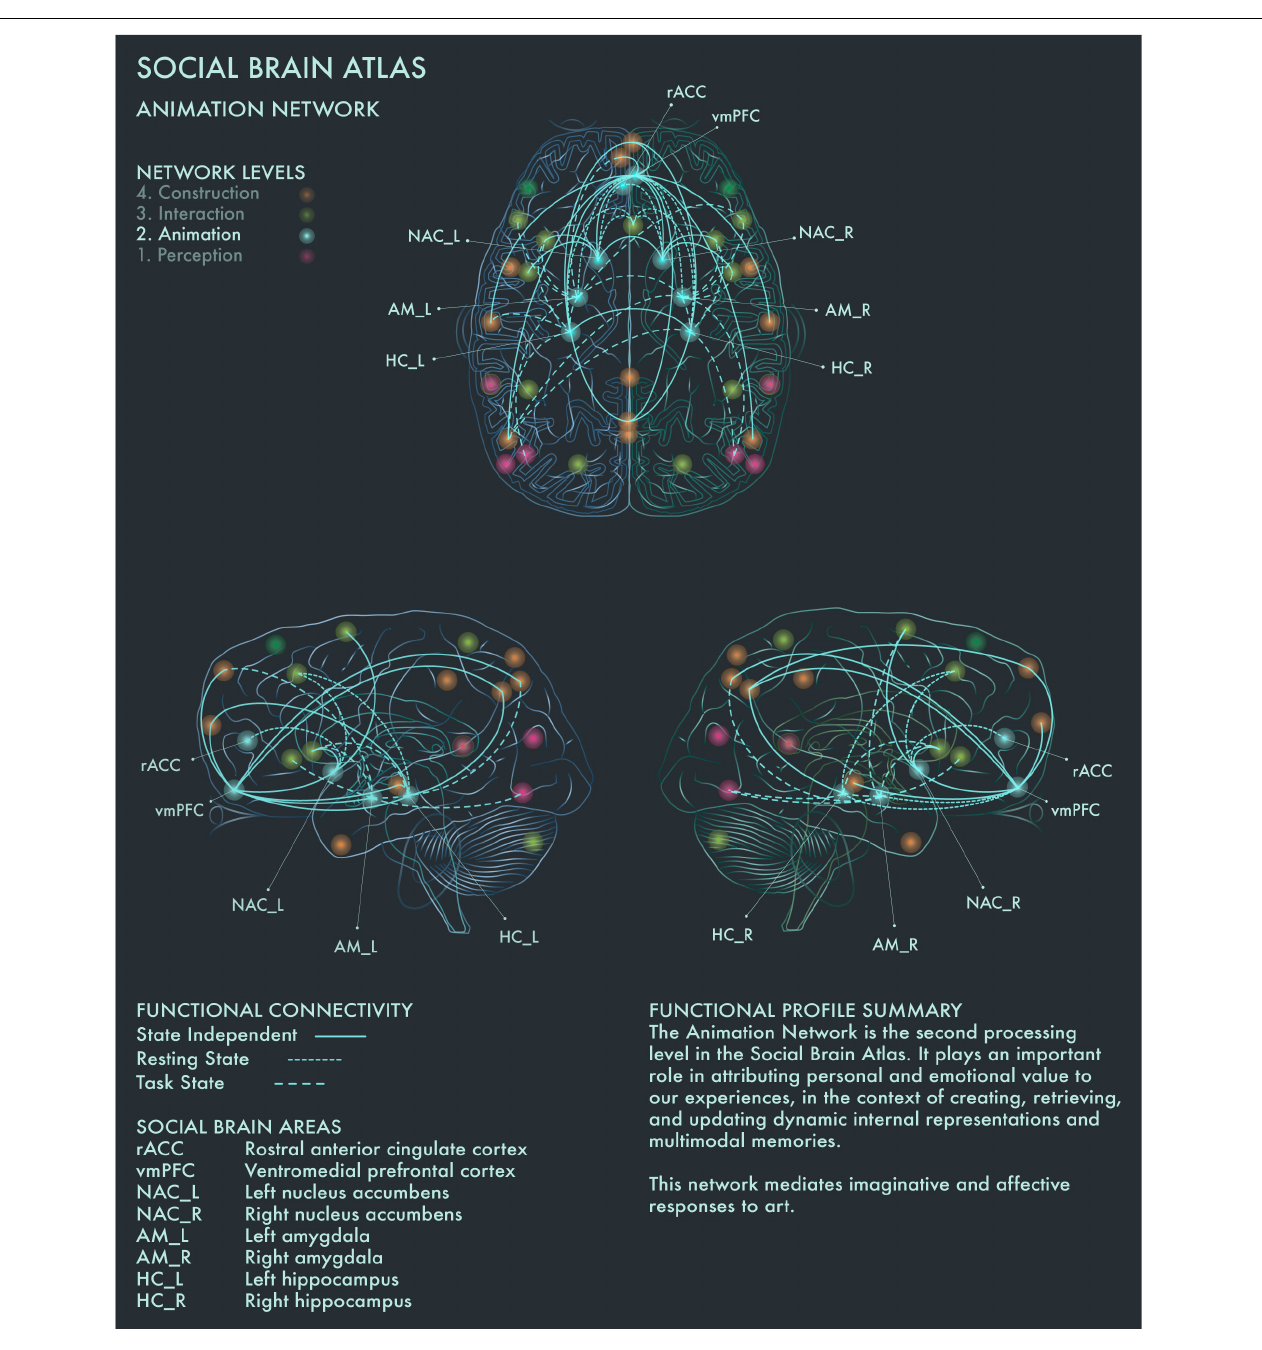
FIGURE 2 | Social Brain Atlas Level 2: Animation Network. This figure shows the functional connectivity patterns of the Animation Network (AN), based on data derived from Alcalá-López et al. (2017) (see also Table 1(B) ). Graphical conventions are the same as Figure 1 . The core nodes of the AN have been labeled as follows: Rostral anterior cingulate cortex (rACC); Ventromedial prefrontal cortex (vmPFC); Bilateral nucleus accumbens (NAC_L/R); Bilateral amygdala (AM_L/R); Bilateral hippocampus (HC_L/R). The AN is the second processing level in the social brain connectome. It plays an important role in attributing personal and emotional value to our experiences, in the context of creating, retrieving, and updating dynamic internal representations and multimodal memories. This network mediates imaginative and affective responses to